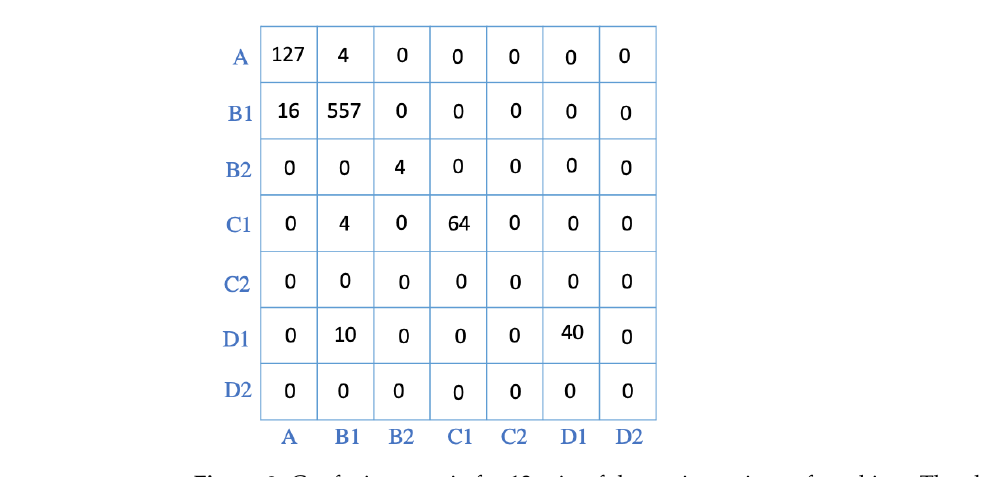
Figure 8. Confusion matrix for 13 min of dynamic motions of a subject. The classes are consistent with the definition of labels presented in Section 3.1. Table 4. RMSE values for each sensor for the next 32 steps ahead in time, and for each subject.